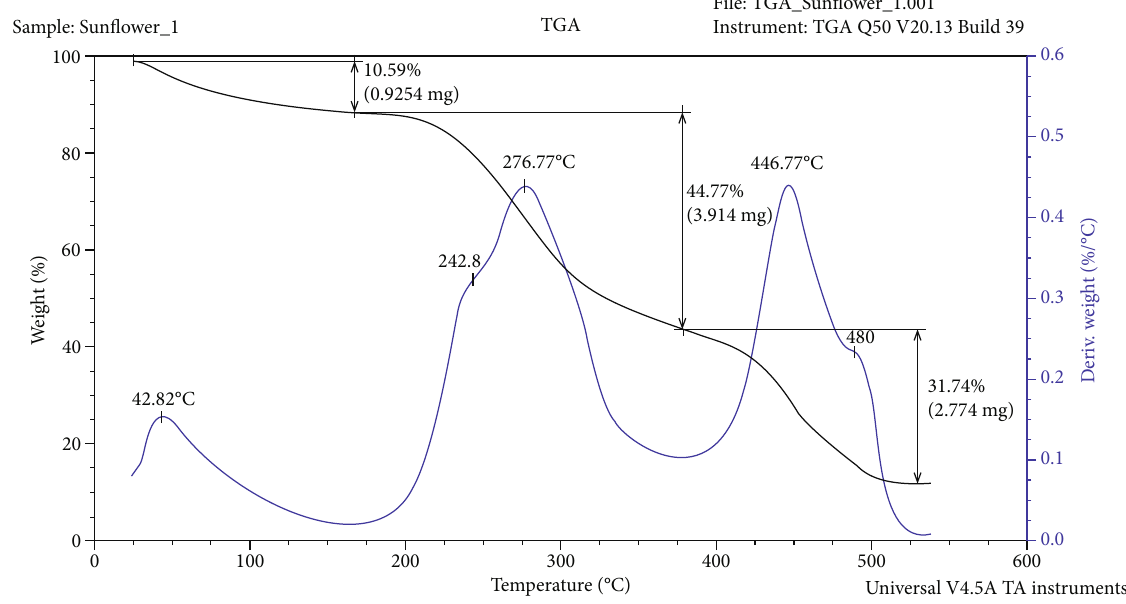
Figure 2: Thermal gravimetric analysis of deproteinized ethanol-treated sun fl ower meal.